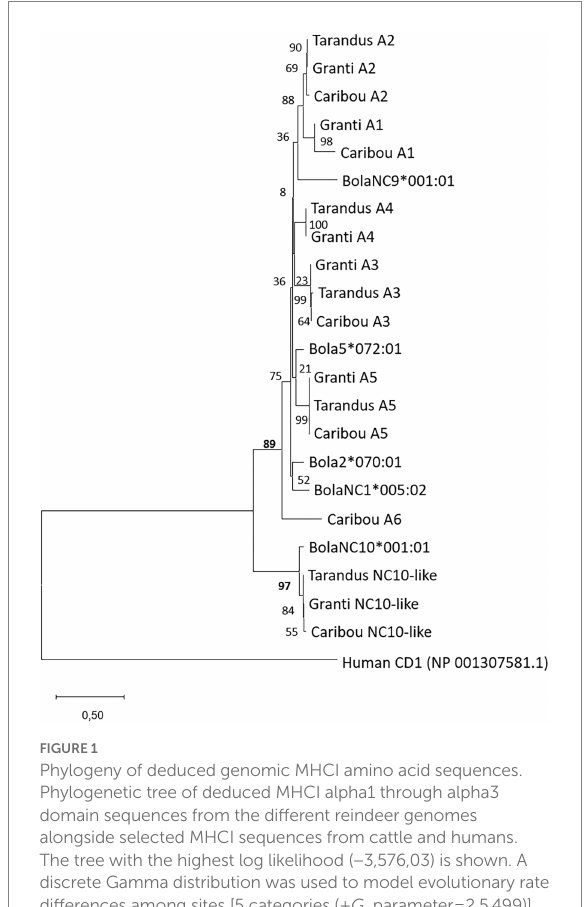
FIGURE 2 Phylogeny of DRB1 and DQB sequences. Phylogenetic tree of nucleotide sequences of amplicon region from the different reindeer samples alongside selected MHCII sequences from the three reindeer genomes. Red, blue, orange and green colored boxes show amplicon clades. The tree with the highest log likelihood (−3,061,43) is shown. A discrete Gamma distribution was used to model evolutionary rate differences among sites [5 categories (+ G , parameter = 0,8,885)]. This analysis involved 41 nucleotide sequences with 433 positions in the final dataset. See Supplementary data for sequences and sequence